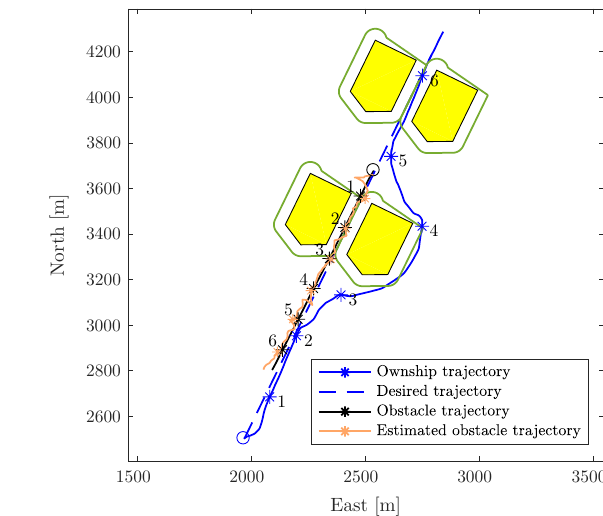
Figure 10: Scenario 1: Static-only scenario. The desired trajectory intersects with two obstacles, which the ownship successfully avoids. The blue cir- cle denotes the initial position, while the num- bers and asterisks mark each 60 s of the experi- ment. The yellow patches show the static obsta- cles, while the dark green contour lines show the padding regions.